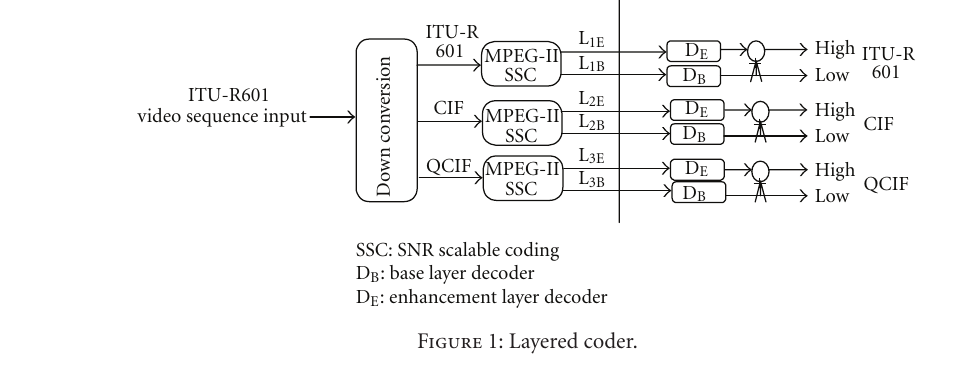
Figure 1: Layered coder.